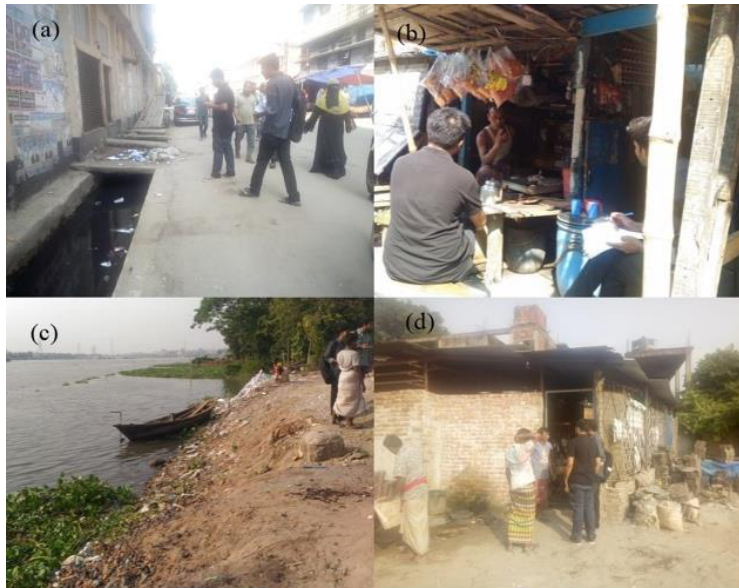
Figure 2 : Data collection of the study area (a) observing drainage conditions at Hazaribag while group discussion, (b) collecting information from the local businessman, (c) observing Buriganga river while survey, and (d) KII with a tannery